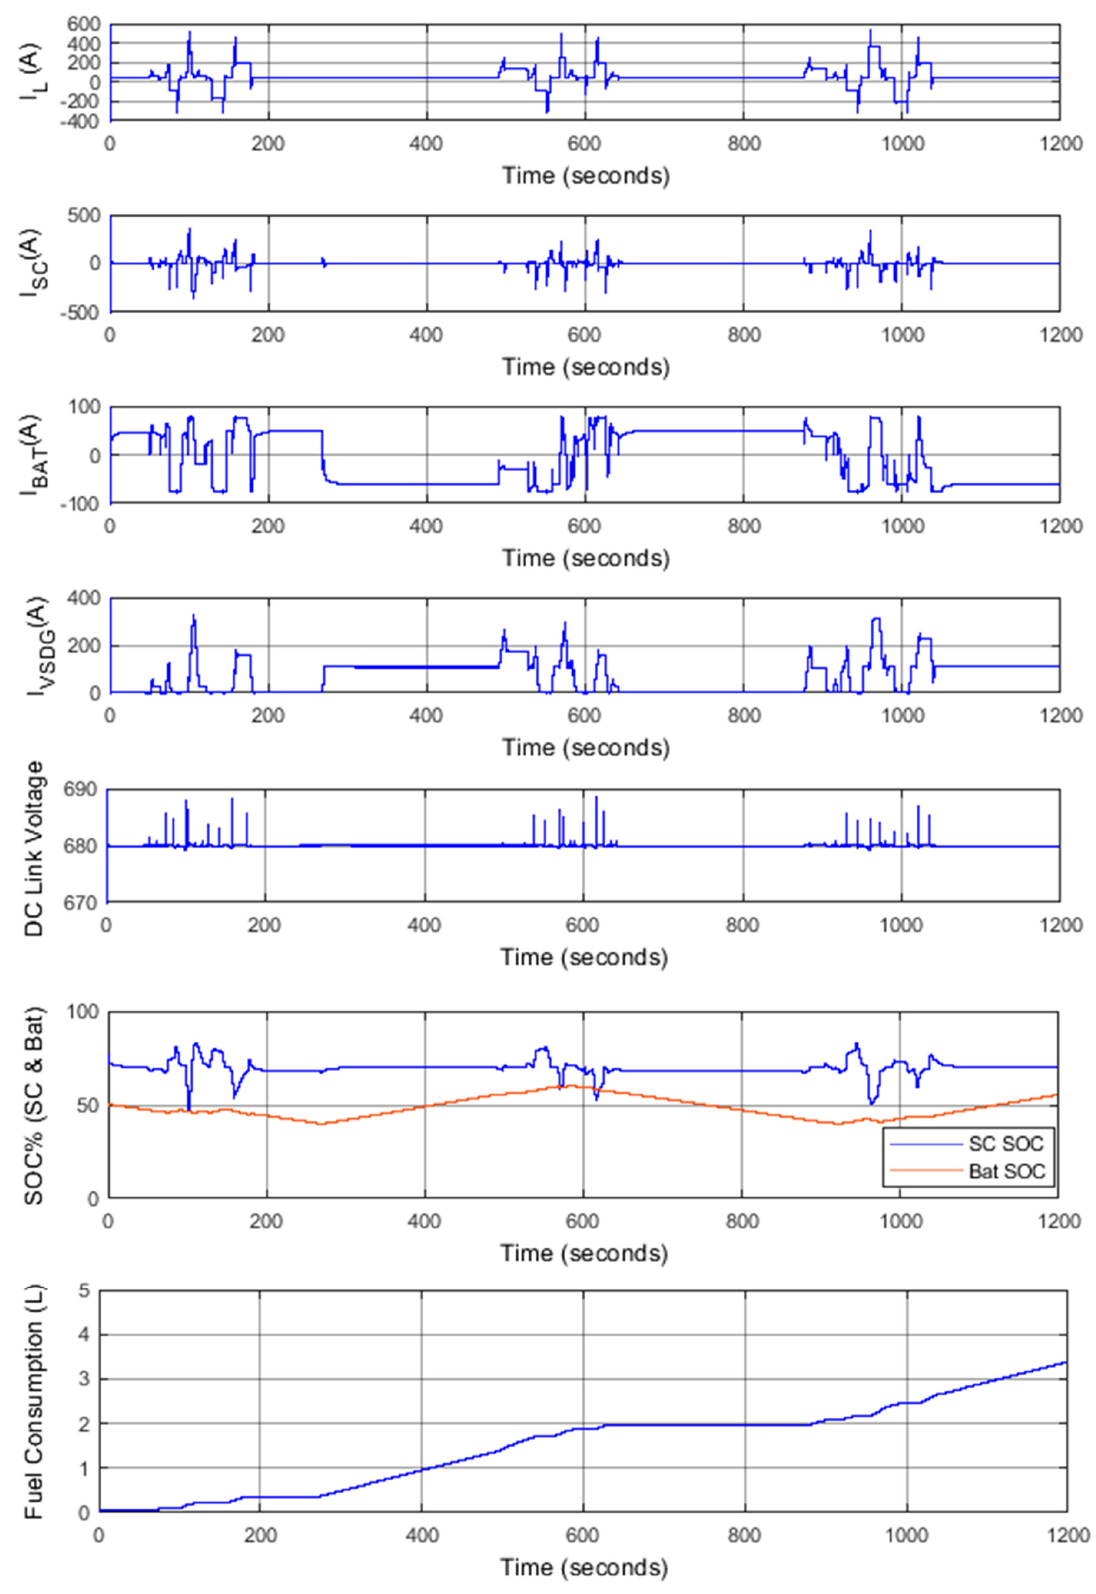
Figure 14. SOC and current variations of Case 3